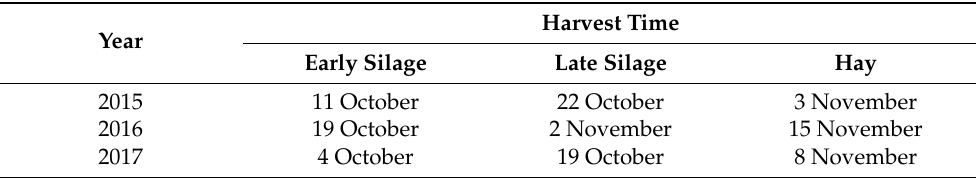
Table 2. Harvest dates of forage crops grown in 2015–2017 at Wagga Wagga, NSW, and forage harvested at three times.